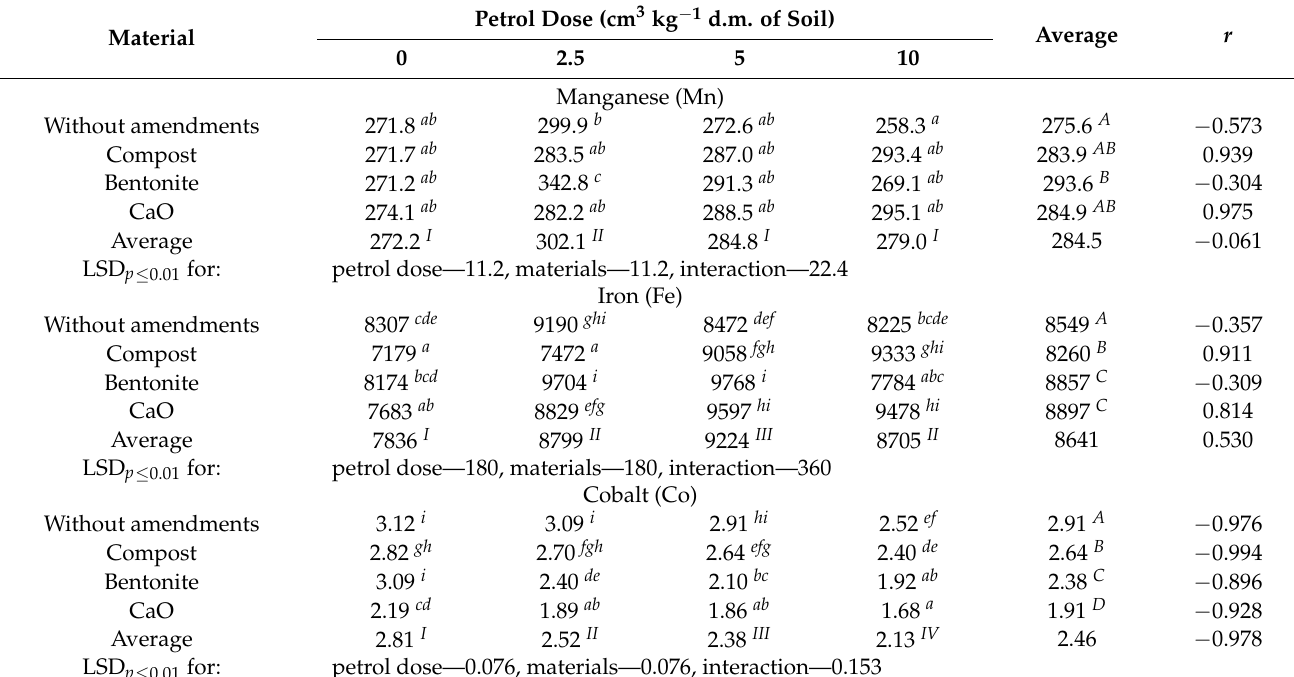
Table 3. The content of manganese, iron, and cobalt in the soil (mg kg − 1